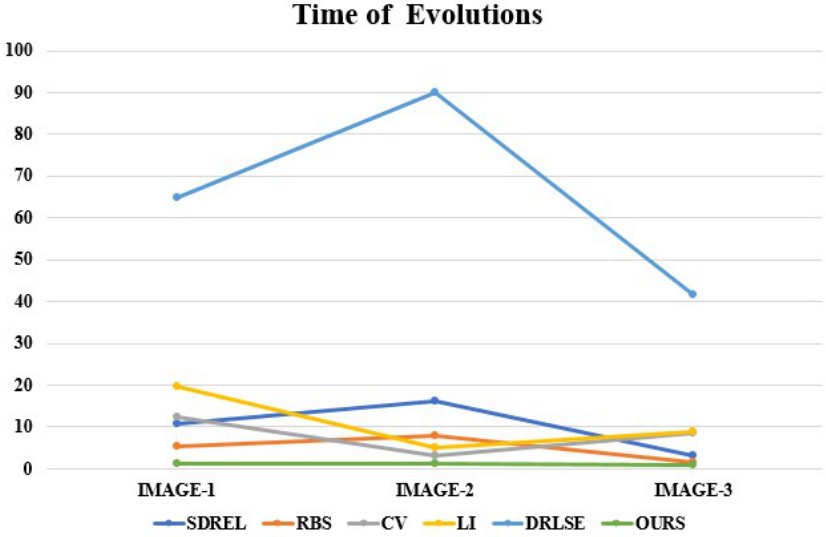
Figure 6. Comparison of our algorithm with five methods on the basis of time in seconds.